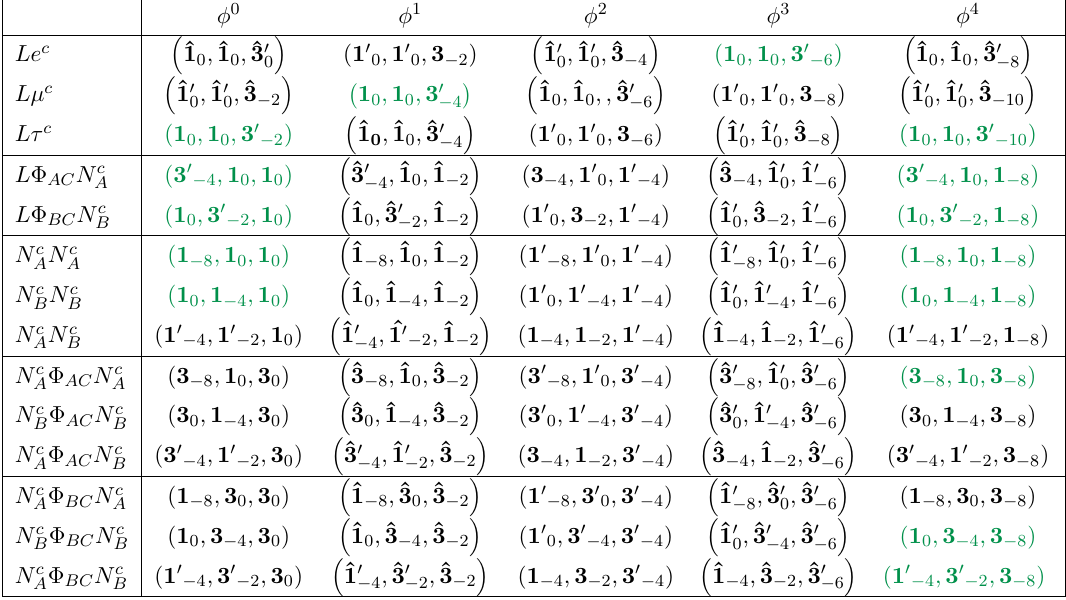
Table 9 . Irreps of the leptonic tensor products with different powers of the weighton following the new assignments. The invariant combinations are highlighted in